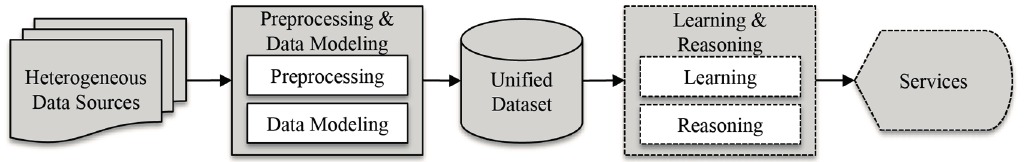
Figure 2. Global unified data model for generating unified dataset.